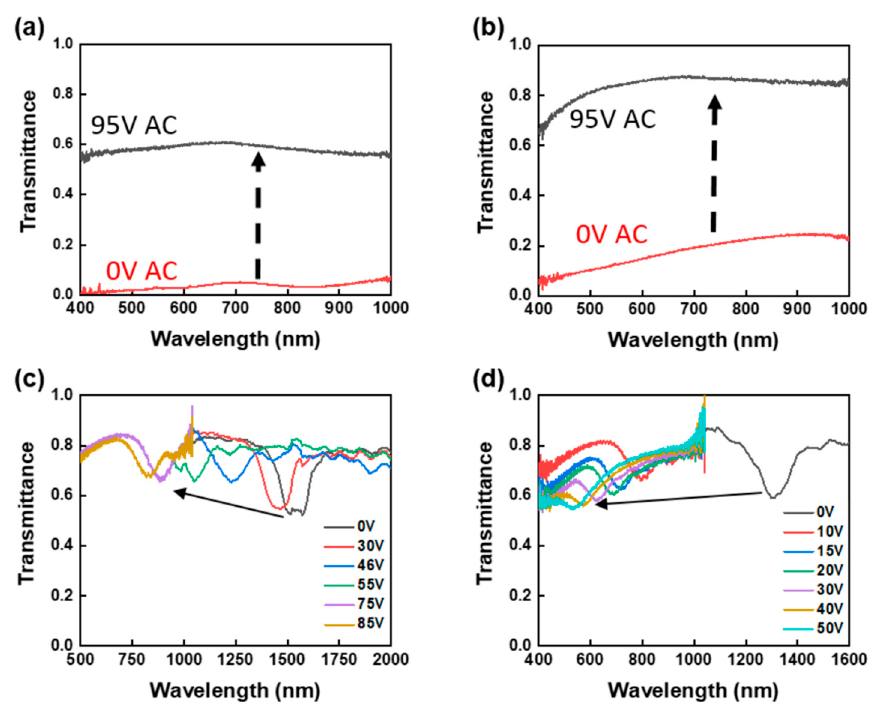
Figure 6. Responsive CLC and PSCLC samples of ( a ) normal mode switchable CLC containing 9.5 wt. % LA-Bn in the focal conic state at 0 V AC and the homeotropic state at 95 V AC. ( b ) Normal mode switchable CLC containing 10 wt. % LA-Me in the focal conic state at 0 V AC and the homeotropic state at 95 V AC. ( c ) Blue tuning PSCLC containing 9.9 wt. % LA-Bn. ( d ) Blue tuning PSCLC containing 10.2 wt. % LA-Me.